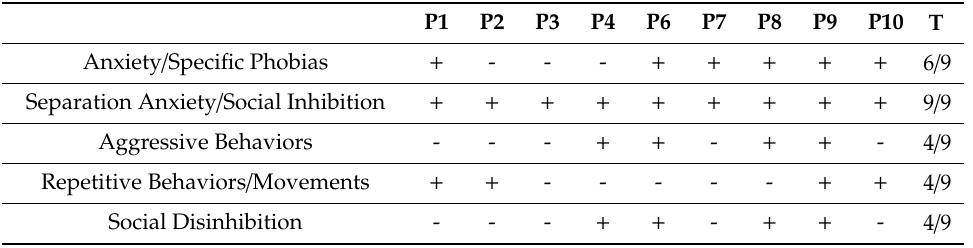
Table 4. Presence / absence of anxiety / phobias, aggressive behaviors, separation anxiety / social inhibition, and repetitive behaviors / movements, disinhibition.